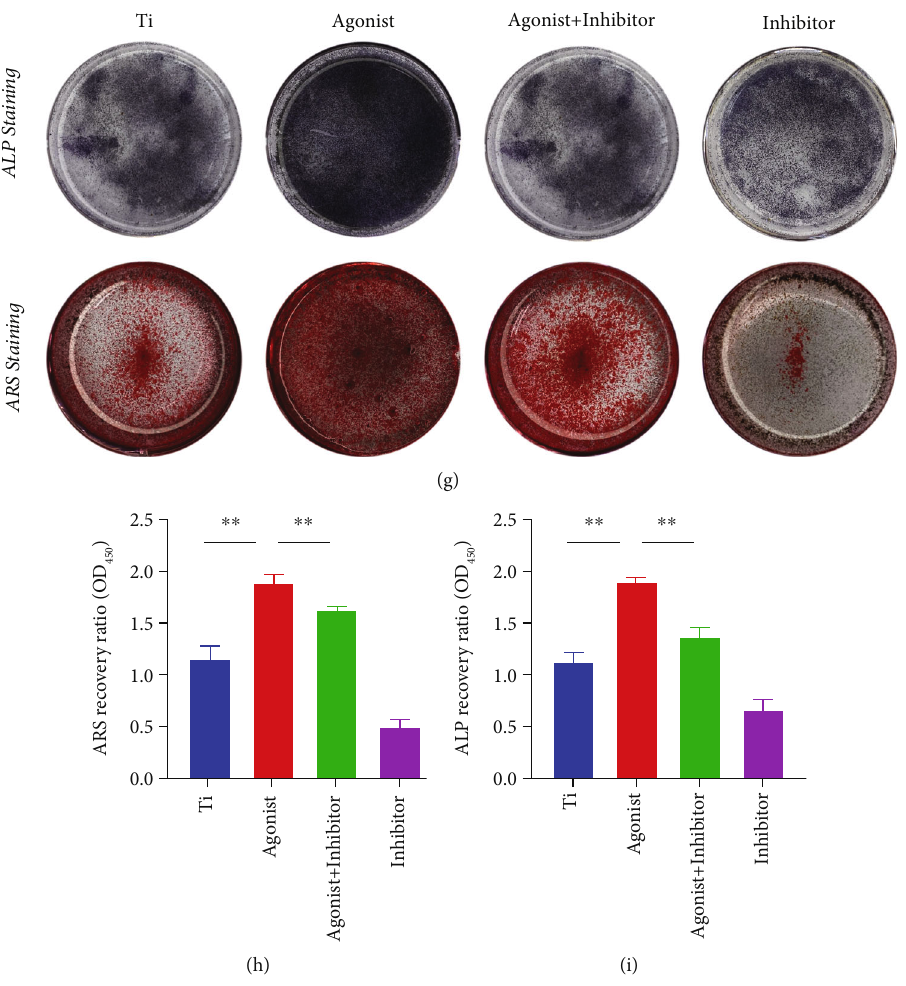
Figure 3: D1R activation abrogates osteogenesis inhibition caused by titanium particles in vitro . (a, b) Cell viability of MC3T3-E1 cells treated with D1R agonists and inhibitors was measured by CCK-8 assays. (c) Representative western blots probed with antibodies against OSX, Runx2, and D1R. (d – f) Quanti fi cation of OSX, Runx2, and D1R protein levels. n = 3 per group. NS: no statistical signi fi cance, ∗ P < 0 : 05 and ∗∗ P < 0 : 01 compared to the Ti group (titanium particle intervention group). (g) Representative images of ALP and ARS staining in vitro . (h, i) Quantitative analysis of ALP activity and bone mineralization in BMSC cells in each group. Note: n = 3 per group; ∗ P < 0 : 05 and ∗∗ P < 0 : 01 compared with the Ti